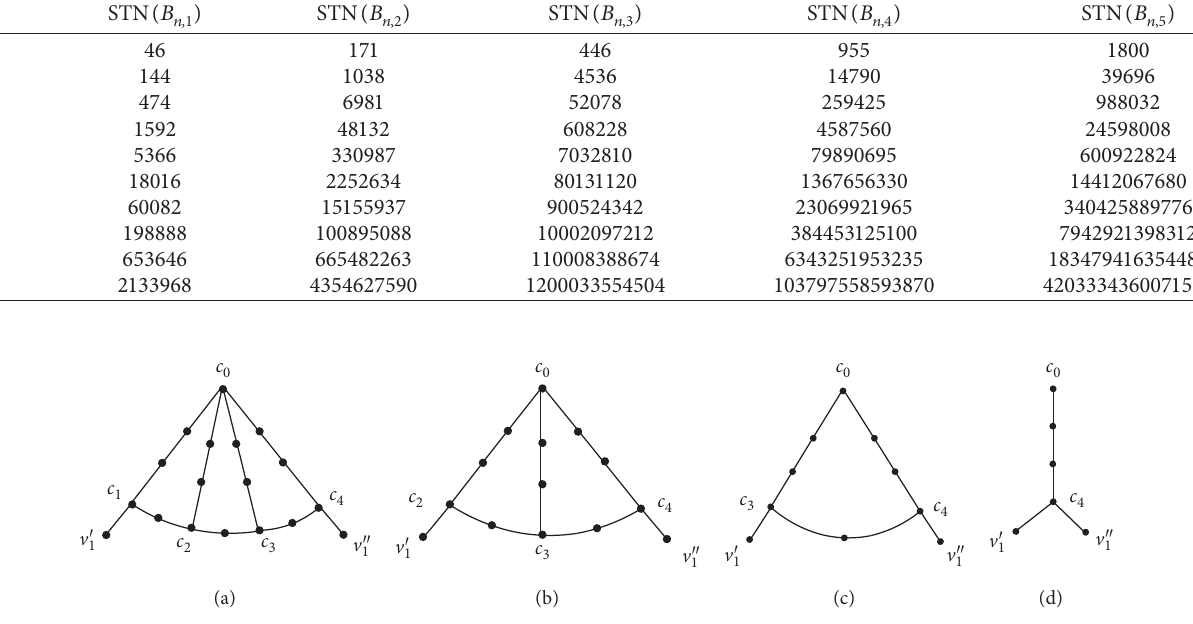
Figure 1: Two-tailed generalized fan graph 􏽥 F 4 ,i